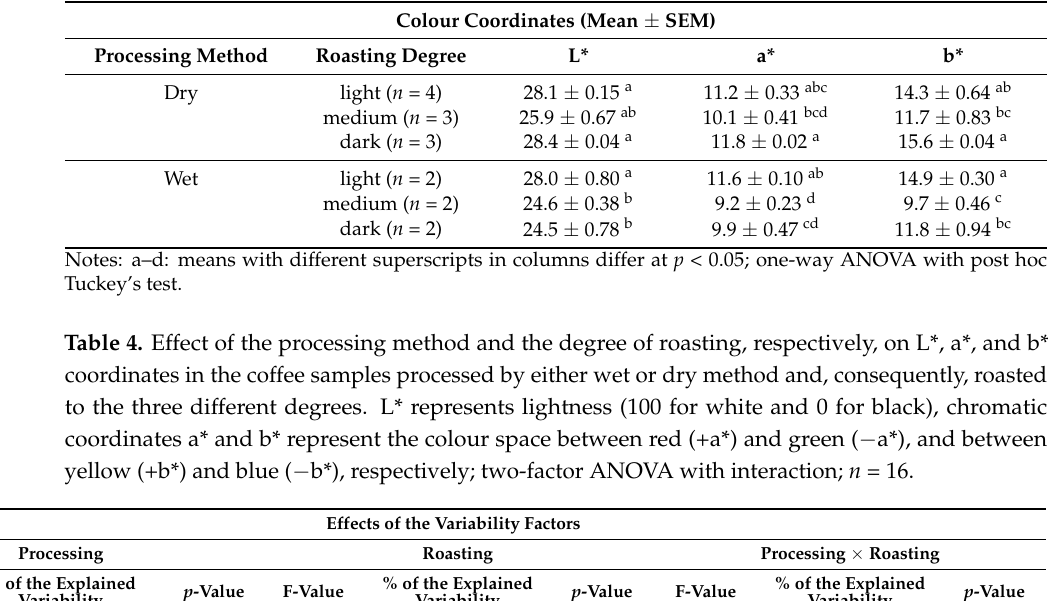
Table 3. Values of the CIELAB coordinates L*, a*, b* in the coffee samples processed by either wet or dry method and, consequently, roasted to three different degrees, light, medium, and dark, respectively. L* represents lightness (100 for white and 0 for black), chromatic coordinates a* and b* represent the colour space between red (+a*) and green ( − a*), and between yellow (+b*) and blue ( − b*), respectively.